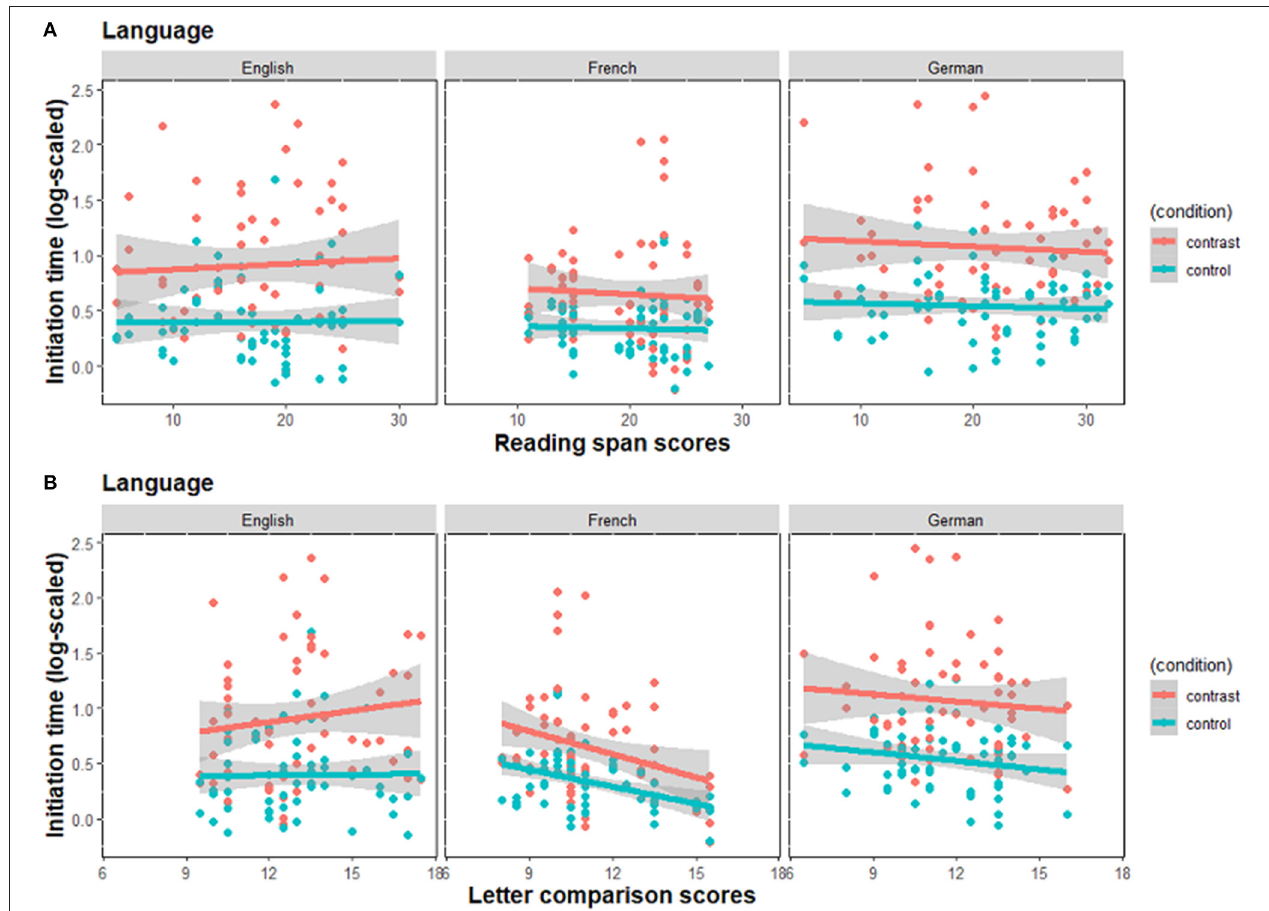
FIGURE 3 | Log-scaled initiation time as a function of (A) working memory scores as measured by the reading span task, and (B) speed of processing scores as measured by the letter comparison task. The gray bands represent 95% confidence interval for the regression lines. Contrast, Contrast condition; control, Control